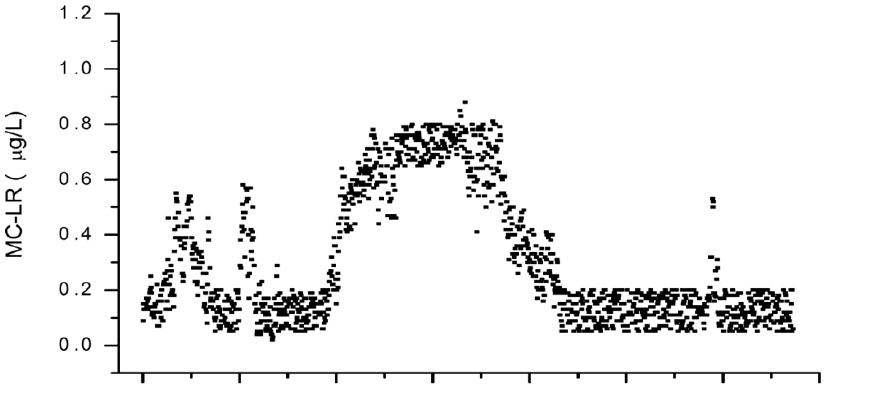
Figure 4. Long-term measurements of microcystin-LR in Lake Tai, China. Reprinted with permission from [135]. Copyright 2013 American Chemical